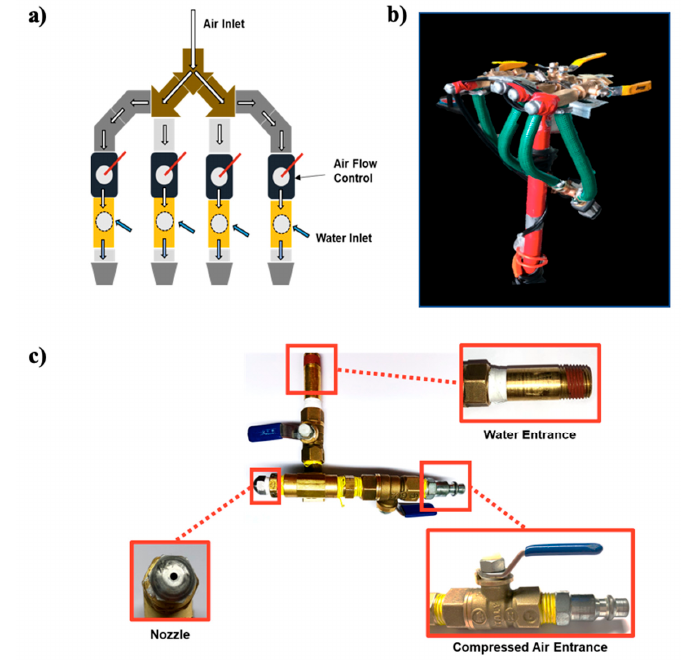
Figure 1. ( a ) Schematic of a snow gun with four nozzles that forms the snow by mixing air and water with controlled pressure. ( b ) The UToledo snow gun with four nozzles. Each nozzle has its own ball valve for controlling air and water flow. ( c ) The components of a single nozzle snow gun. The water entrance, compressed air entrance, and nozzle are depicted. The air and water entrance can be controlled by the corresponding ball valves, which in turn controls the LWC of snow.